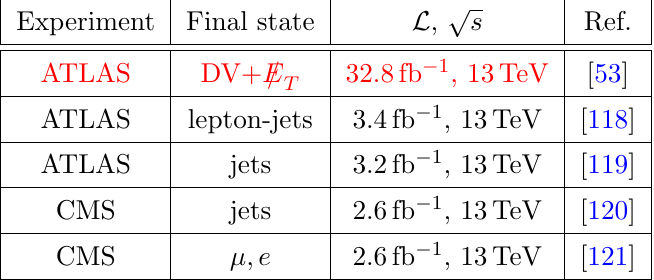
Table 1 . Summary of 13 TeV ATLAS and CMS searches for displaced signatures possibly relevant for the (cid:12)nal state under